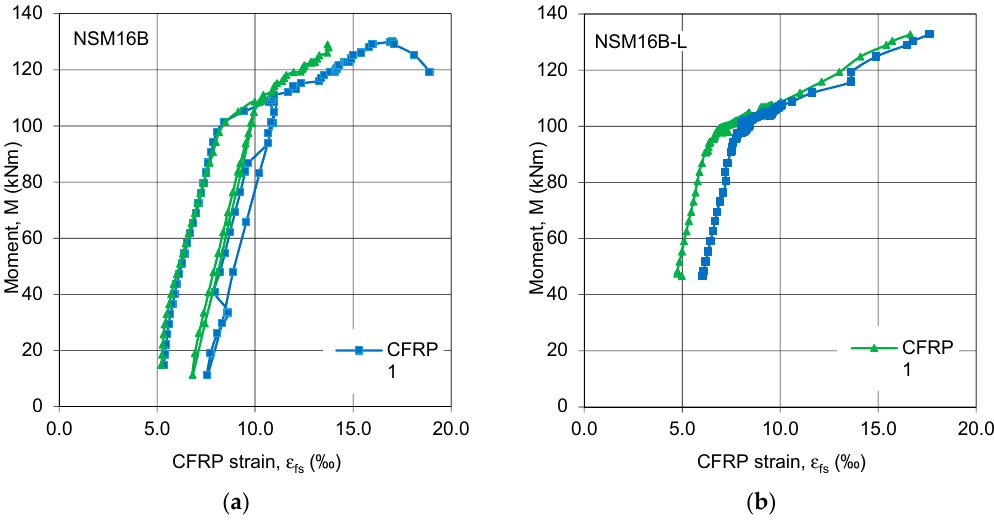
Figure 11. Bending moment vs. CFRP strain curves of series B: ( a ) NSM16B; and ( b ) NSM16B-L. Table 4. Summary of CFRP strain and deflections after pretensioning.